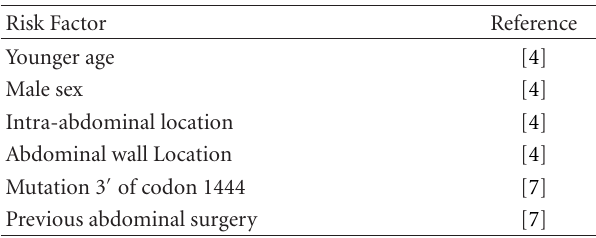
Table 1: Demographic risk factors for desmoid development among FAP